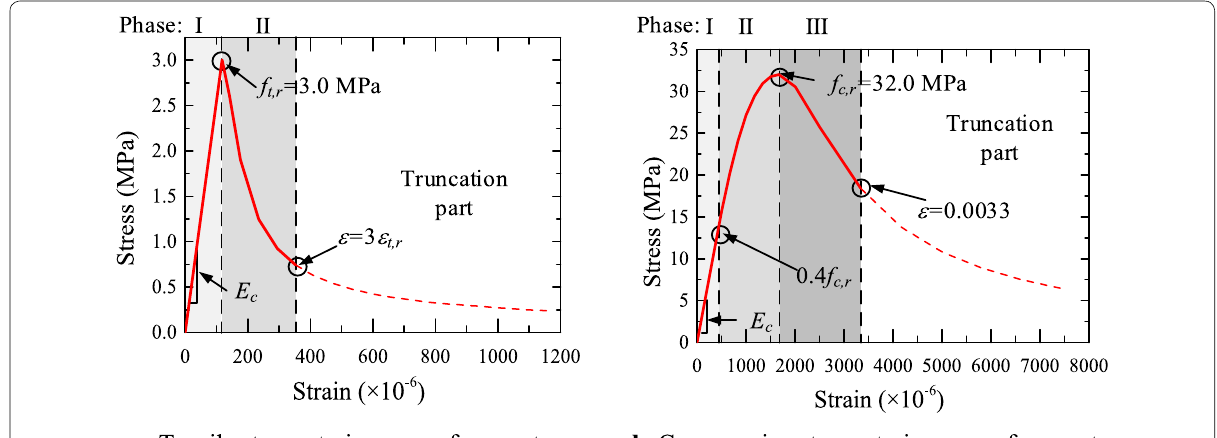
Fig. 15 Constitutive relationships of